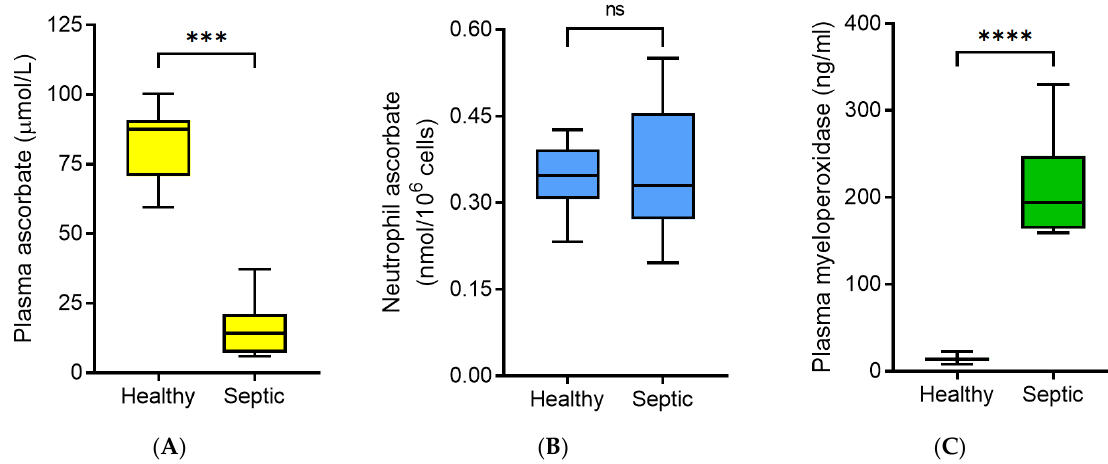
Figure 1. Ascorbate and myeloperoxidase concentrations in healthy volunteers and septic patients. The ascorbate concentrations of ( A ) plasma and ( B ) neutrophils from healthy volunteers ( n = 7 for plasma and n = 13 for neutrophils) and septic patients ( n = 9 paired plasma and neutrophil samples) were determined by HPLC. ( C ) Plasma myeloperoxidase concentrations from healthy volunteers ( n = 13) and septic patients ( n = 9) were determined by ELISA. Box plots show medians with 25th and 75th percentiles as boundaries and whiskers indicate the range. Mann–Whitney U tests indicated significant differences for plasma ascorbate (*** p < 0.001) and myeloperoxidase (**** p < 0.0001), but not significant (ns) for neutrophil ascorbate ( p > 0.05).